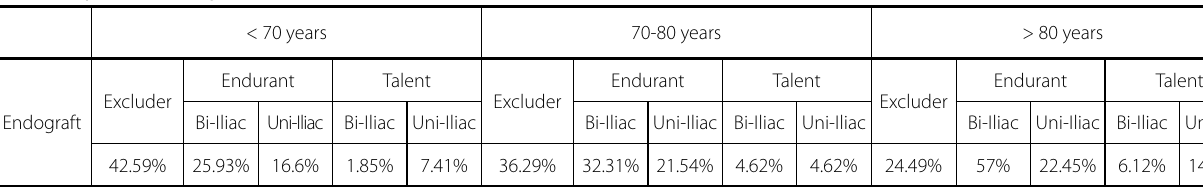
Table 3. Type of endograft used.